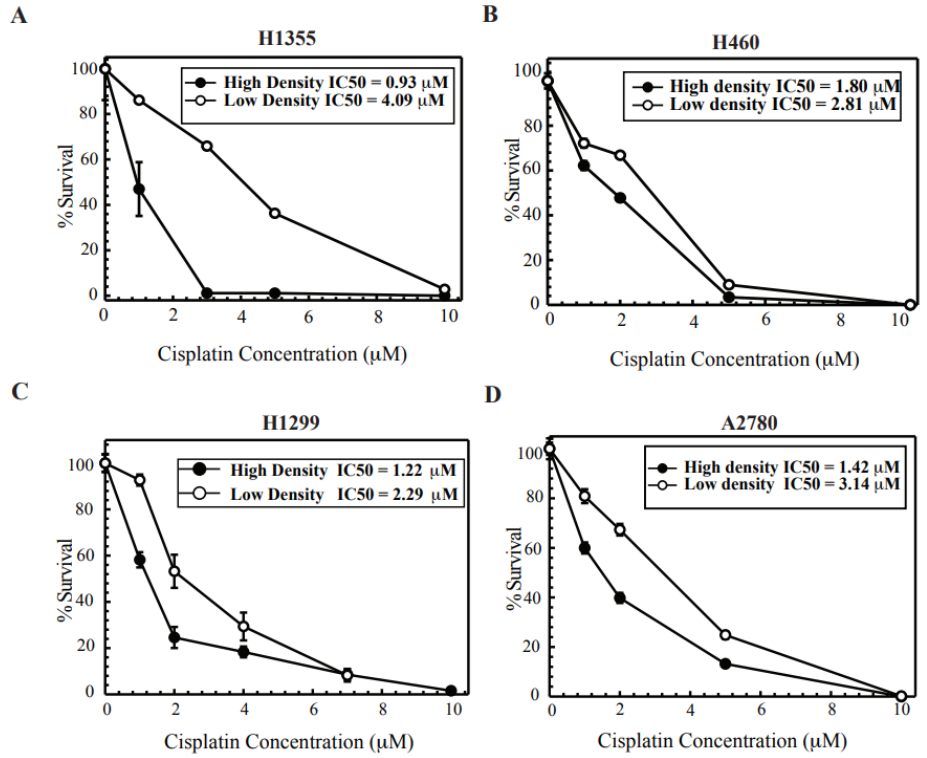
Figure 1. Clonogenic survival after cisplatin treatment at low and high density of cells. ( A ) H1355, ( B ) H460, ( C ) H1299, ( D ) A2780. Clonogenic survival was performed at high-density and low-density